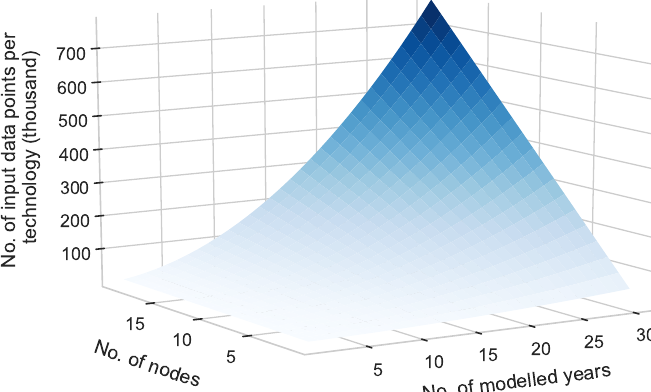
Figure 1. Average number of data points per technology in the input-data set of a MESSAGE ix model in dependence of the number of modelled years and nodes.